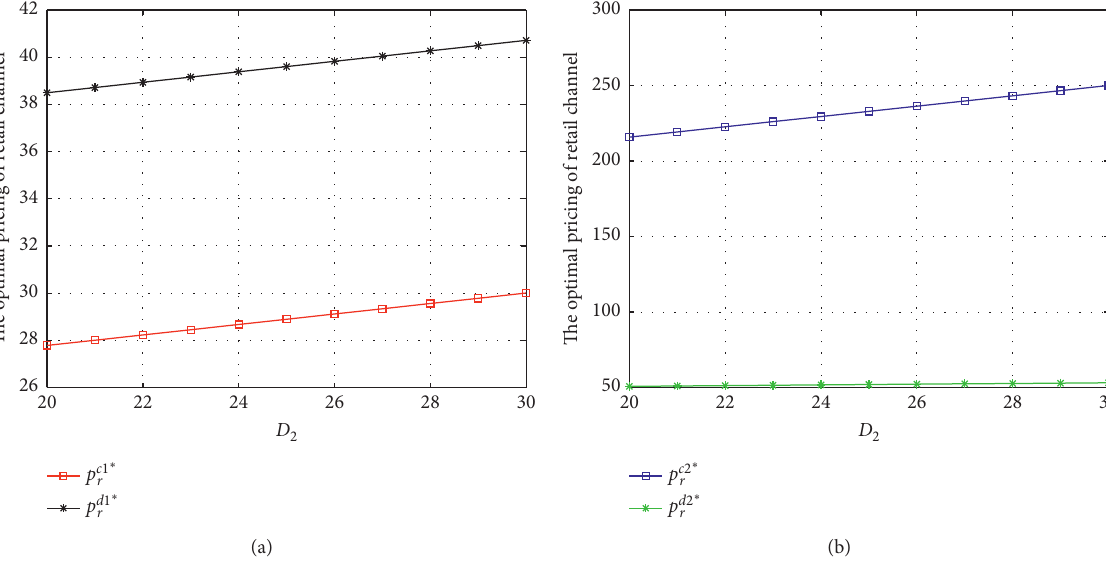
Figure 3: The optimal retail selling price under the centralized and decentralized